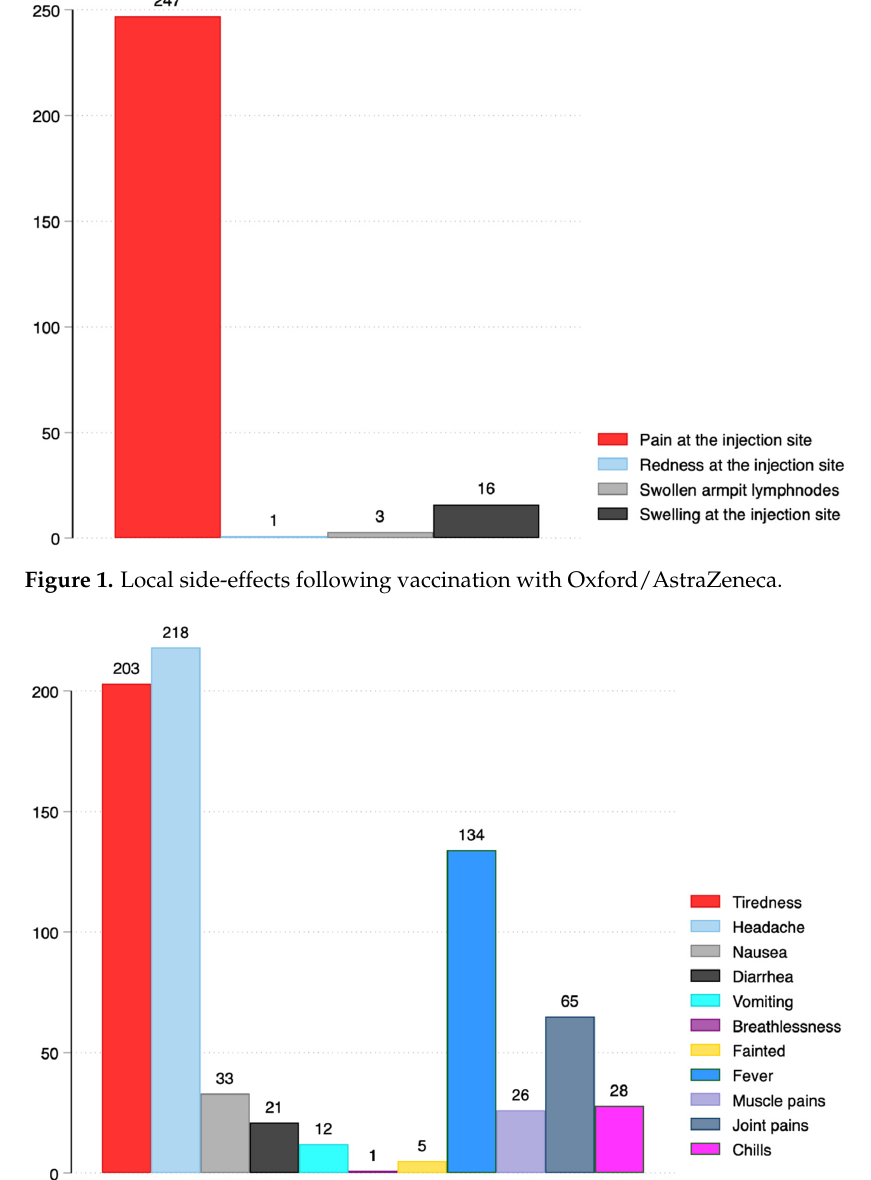
Figure 2. Systemic side-effects following vaccination with Oxford/AstraZeneca.